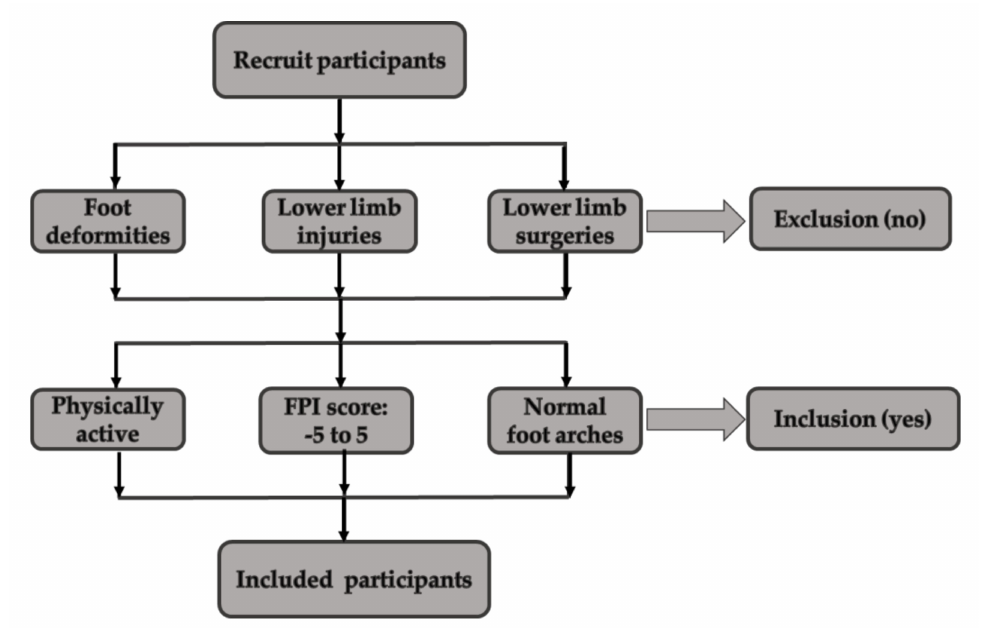
Figure 2. Flow chart of participant selection. Note: FPI-foot posture index.